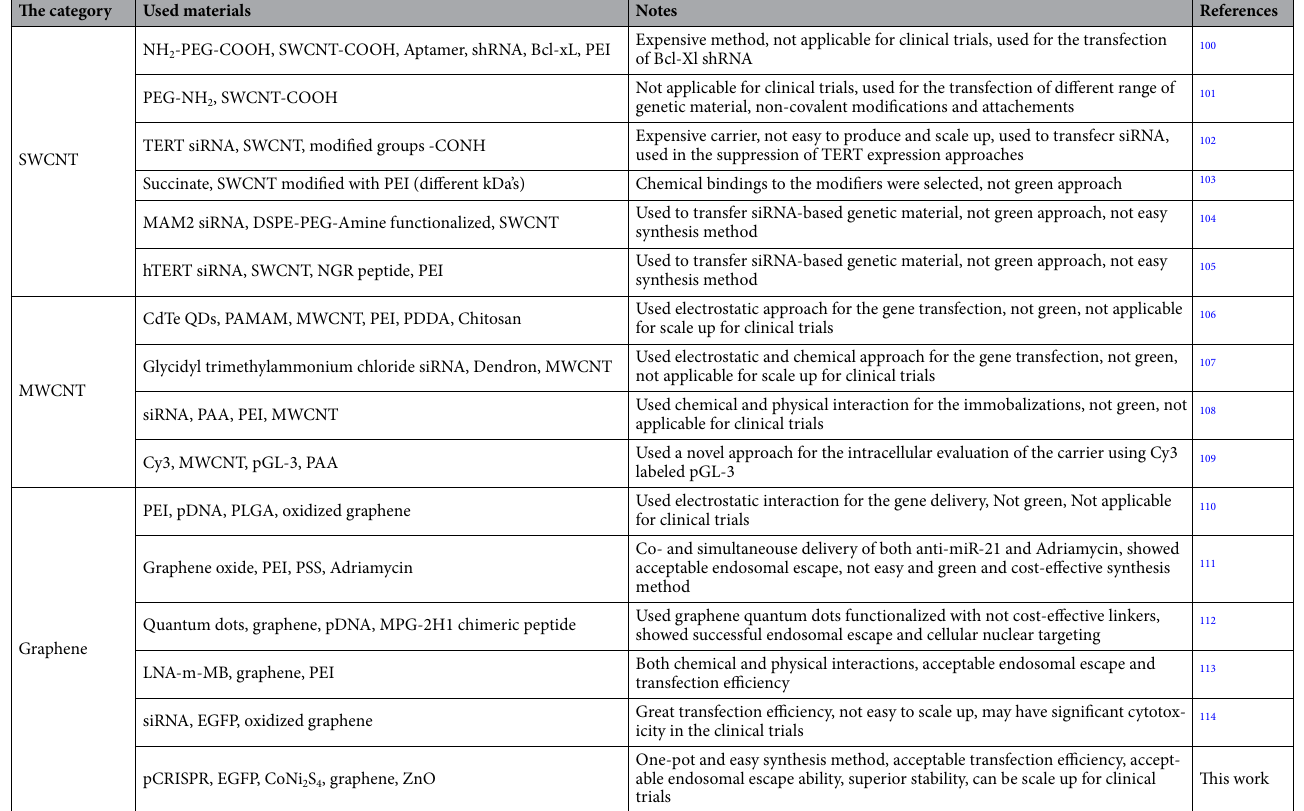
Table 2. A literature survey on the functionalized and modified carbon-based nanomaterials for gene delivery